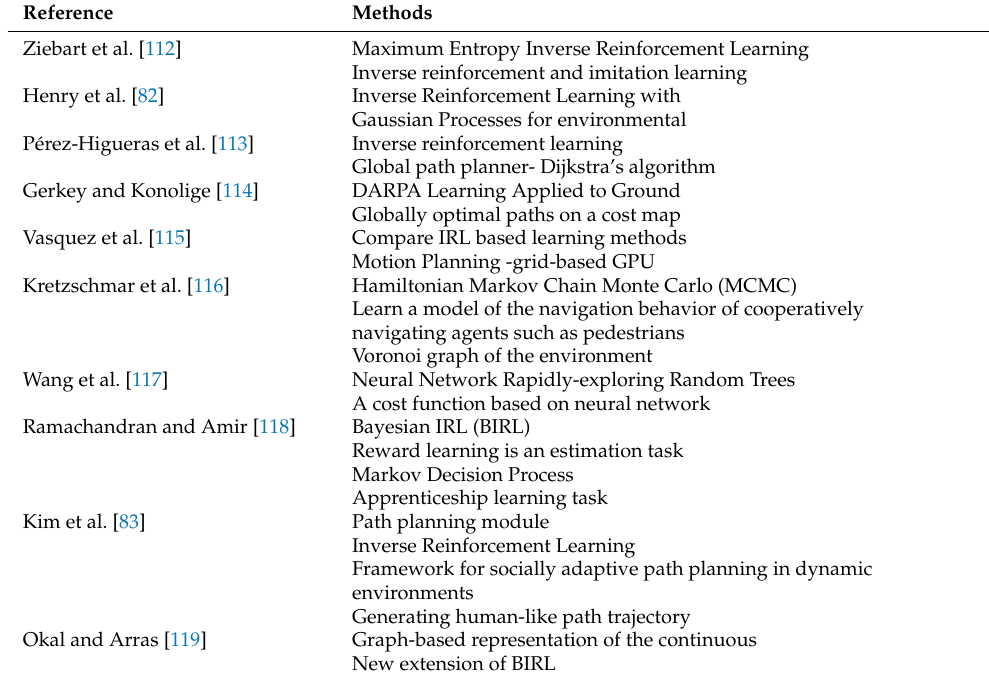
Table 5. Approaches considered in Section 3.3.2. The table covers the reviewed methods for IRL.